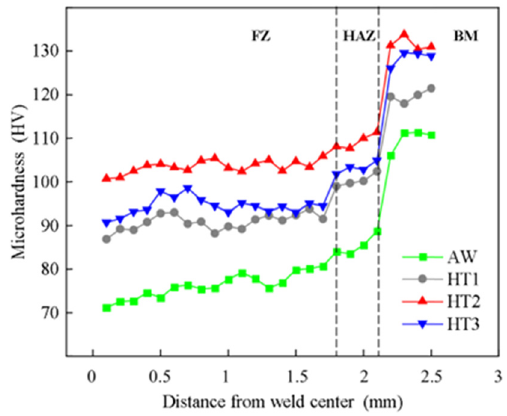
Figure 9: Microhardness distribution curves of joints under di ff erent conditions.